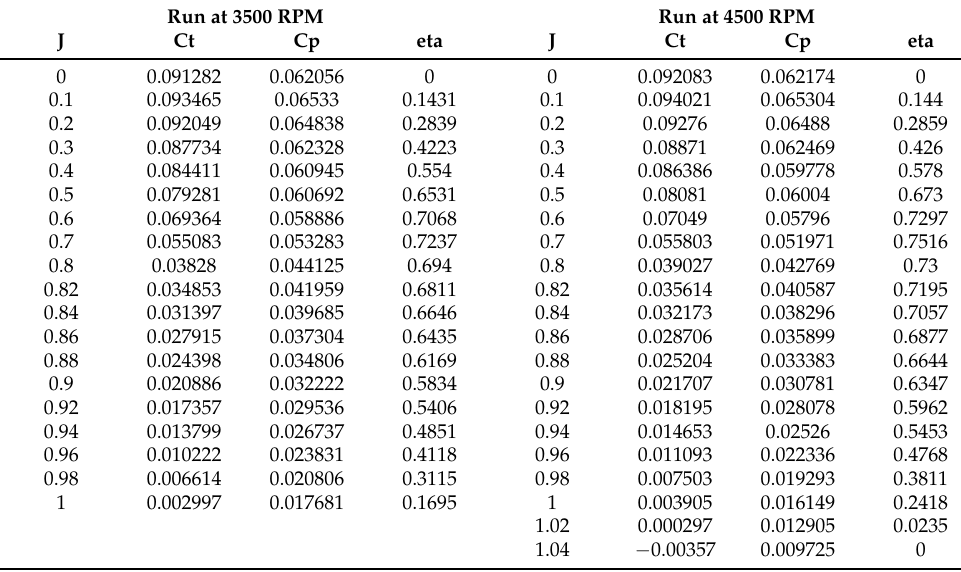
Table A29. BEMT 18 × 14 APC propeller data.